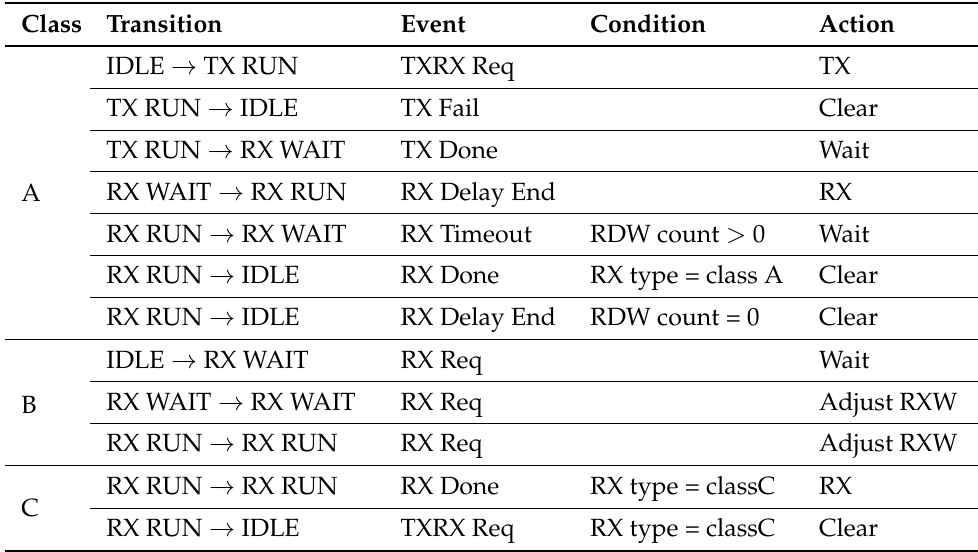
Table 4. State transitions in the LPHY FSM for class A, B and C operations.